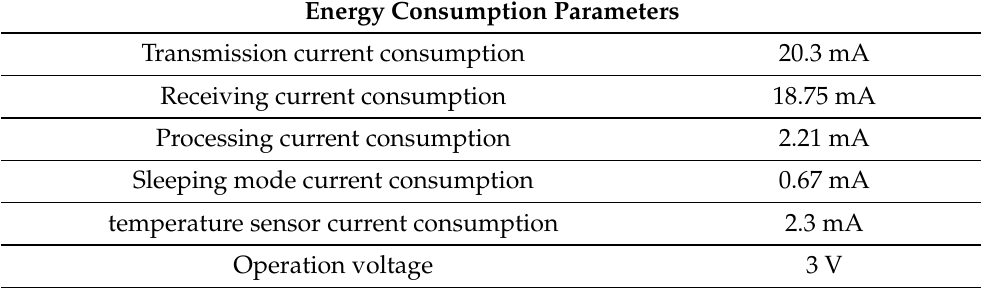
Table 5. Energy consumption